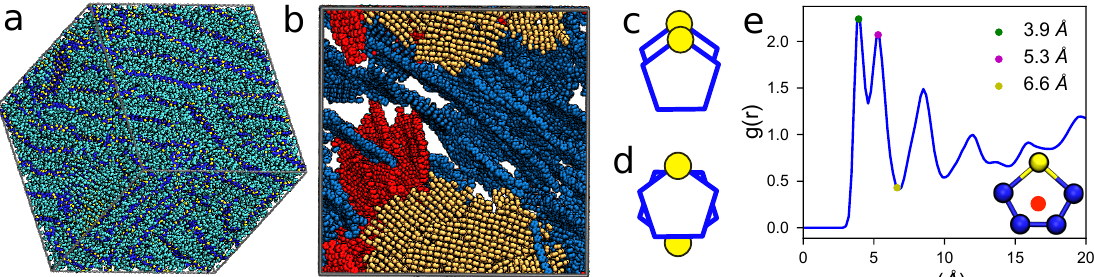
Figure 7. ( a ) a representative ordered molecular morphology of P3HT 15mers (CA-dark blue, S-yellow, CT-cyan) depicting π - and alkyl-stacked lamellae (state-point: implicit charges, T ∼ 600 K, ε s = 0.8, ρ = 1.11 g/cm 3 ); ( b ) the locations of the three largest crystallites in the system (colored blue, red, and yellow in order of descending size). Small crystallites and side chains are omitted for clarity. Within each crystallite, thiophene rings stack in ( c ) an aligned or ( d ) anti-aligned conformation, which are observed in ( e ) the RDF of the thiophene centroid (e-inset) as the green (3.9 Å) and magenta (5.3 Å) dots, respectively. The RDF minimum at 6.6 Å (yellow dot) is used as a clustering criterion describing the maximum separation of two rings in the same